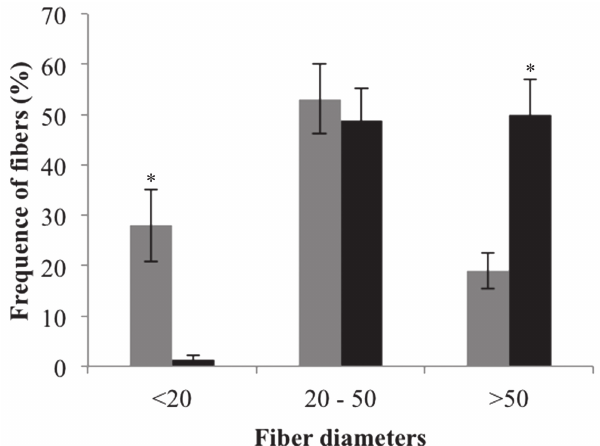
Fig. 4. Frequency of muscle fibers from 300 days old Colossoma macropomum . Significant differences (*) represent the differences between the animal groups according to body weight, 165 to 300 g (black) and 976 to 1,250 g (gray) in each class by ANOVA one-way supplemented by Tukey’s test ( P<0.05 ).